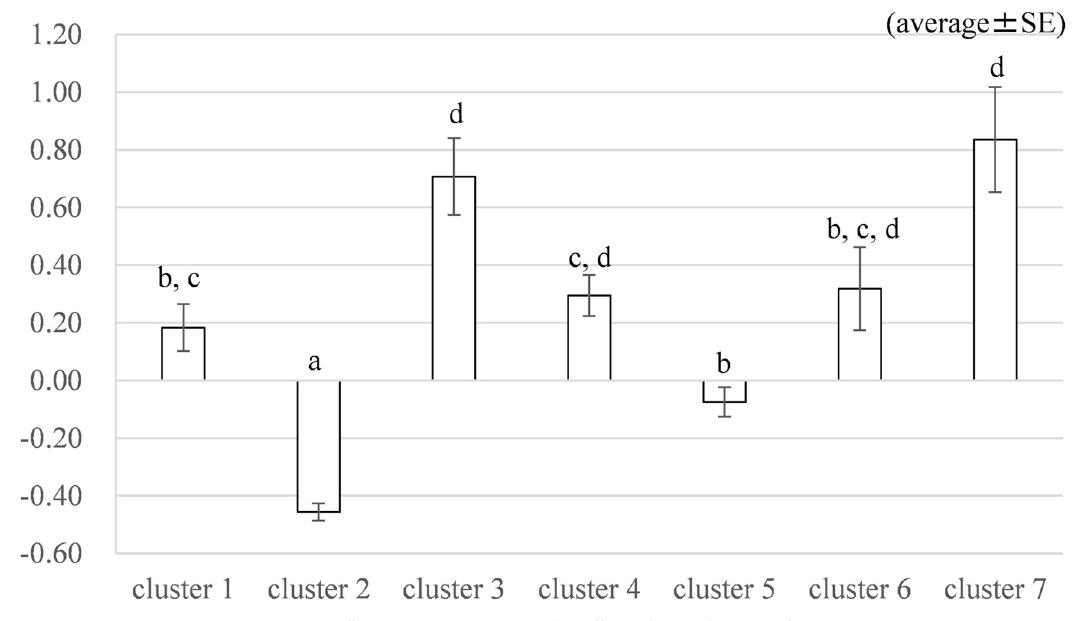
Fig 5. Results of analysis of variance on “health/social knowledge”. Different letters show significance.